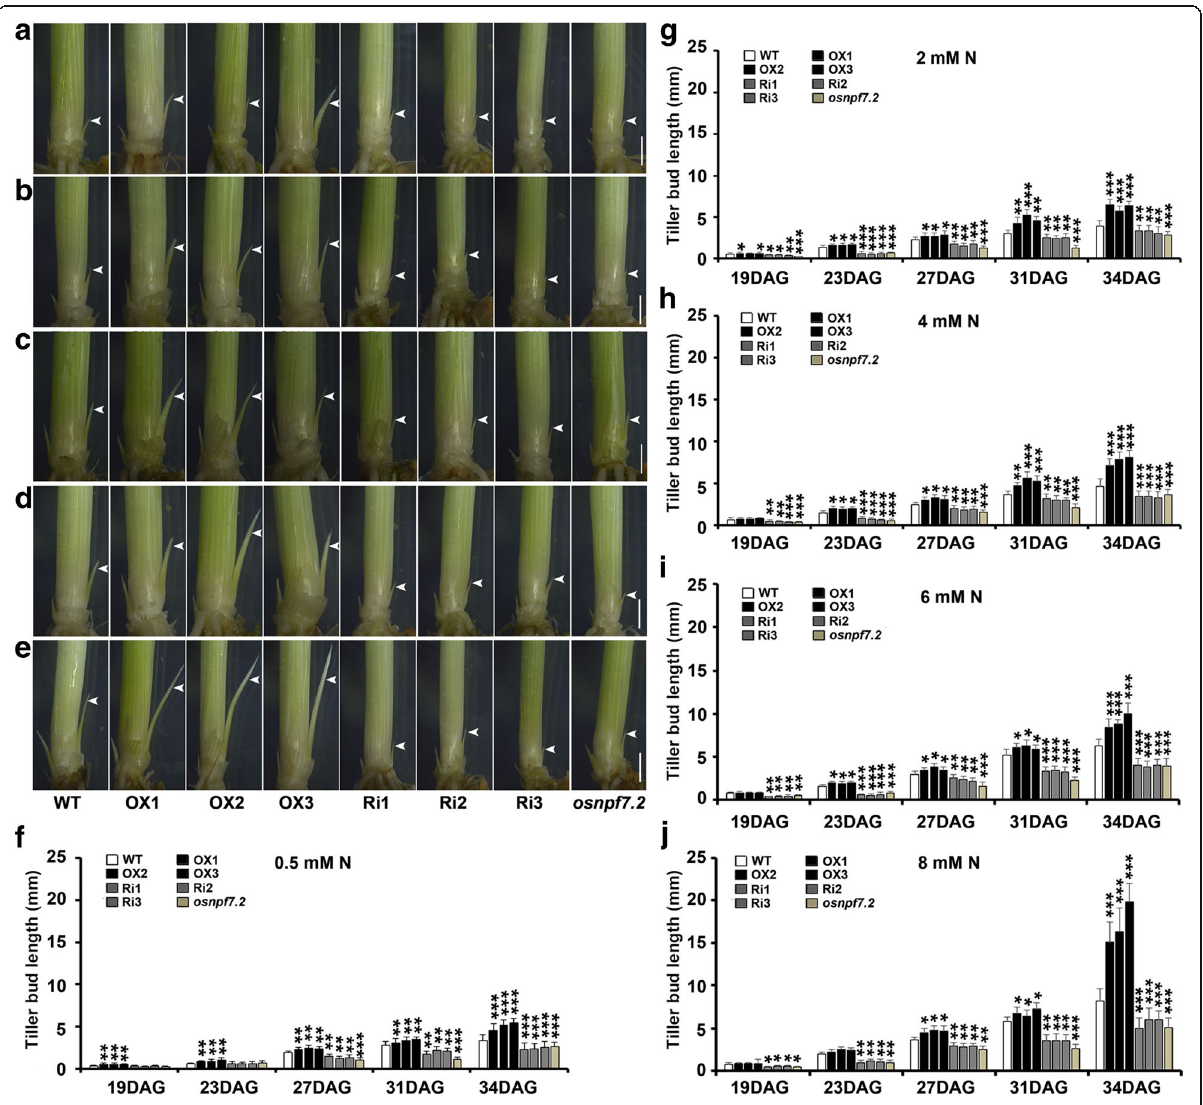
Fig. 2 Altered expression of OsNPF7.2 regulated tiller bud outgrowth under the different nitrate concentration. a-e Comparison of tiller buds among WT, OX lines, Ri lines and osnpf7.2 under the 0.2 mM NaNO 3 , 2 mM NaNO 3 , 4 mM NaNO 3 , 6 mM NaNO 3 and 8 mM NaNO 3 , respectively. White arrows indicated tiller buds, bar = 1 mm. f-j Statistical analysis of the tiller buds length among WT, OX lines, Ri lines and osnpf7.2 under the 0.2 mM NaNO 3 , 2 mM NaNO 3 , 4 mM NaNO 3 , 6 mM NaNO 3 and 8 mM NaNO 3 , respectively. DAG was the abbreviation of days after germination. Values in f-j are shown as mean ± SD ( n = 20) from three replicates; “ * ” , “ ** ” and “ *** ” indicated significant differences at P < 0.05, P < 0.01 and P < 0.001,